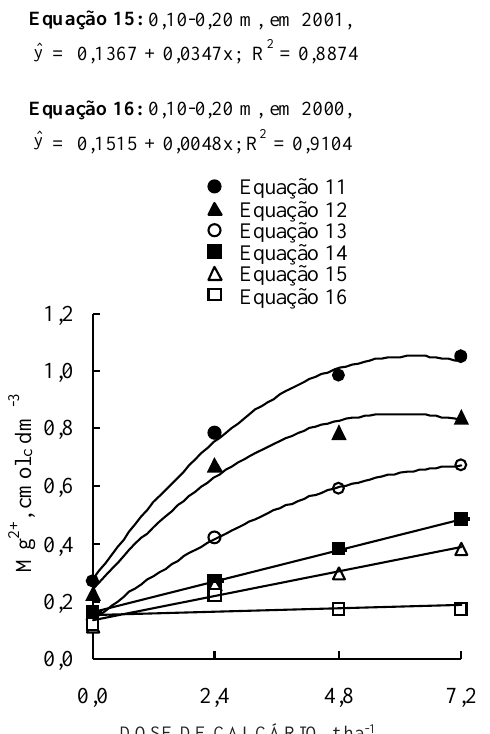
DOSE DE CALCÁRIO, t ha -1 Figura 6. Teores de Mg 2+ de acordo com as doses crescentes de calcário distribuído na superfície do solo em 1999. As equações de regressões (linear e quadrática) variam de acordo com as camadas de solo (0,05–0,10 e 0,10–0,20 m) e anos de amostragem (2000, 2001 e